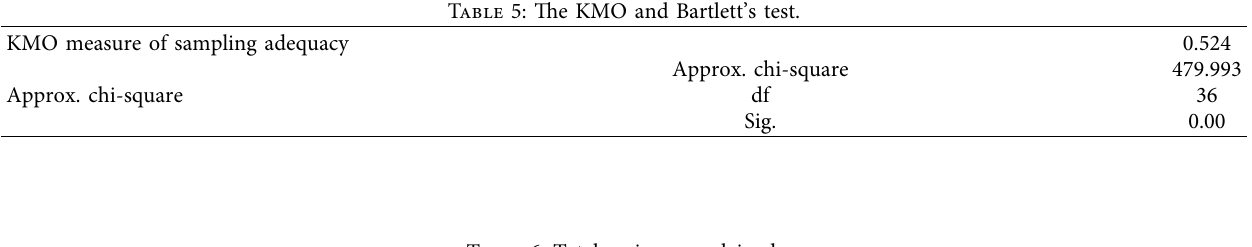
Table 6: Total variance explained.